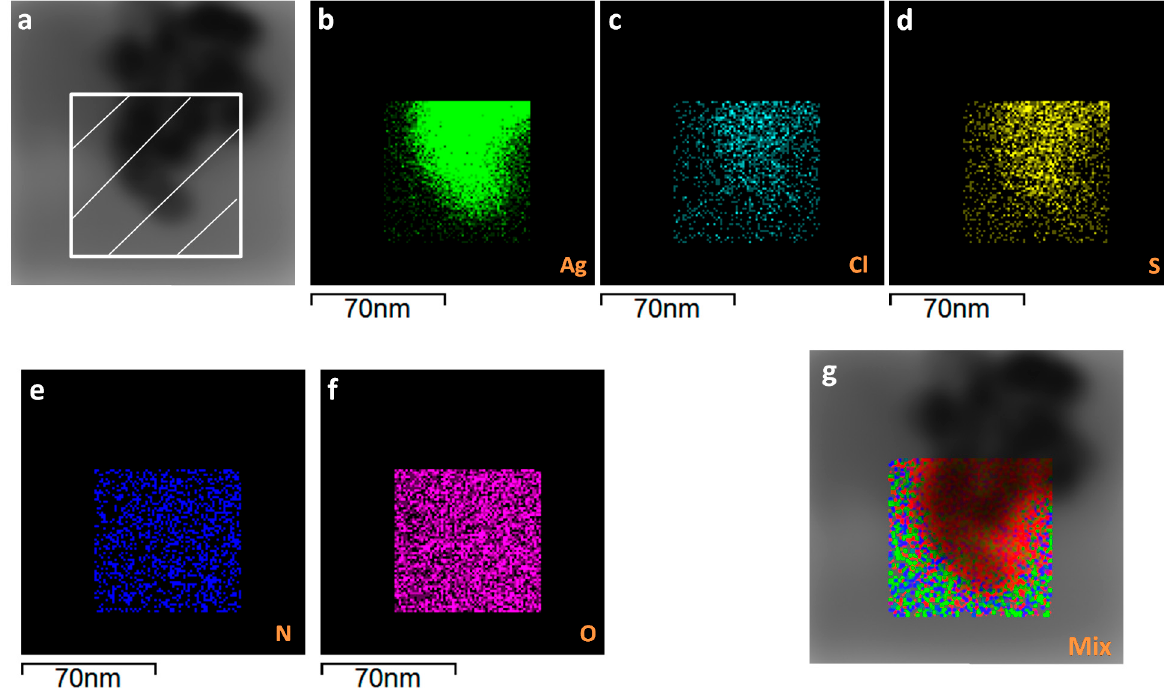
Figure 8. STEM of AgNP@P(PEG350) 3 ( a ) with elemental analysis mapping ( b – f ) in dashed area of image ( a ) and their total merged composition ( g ).